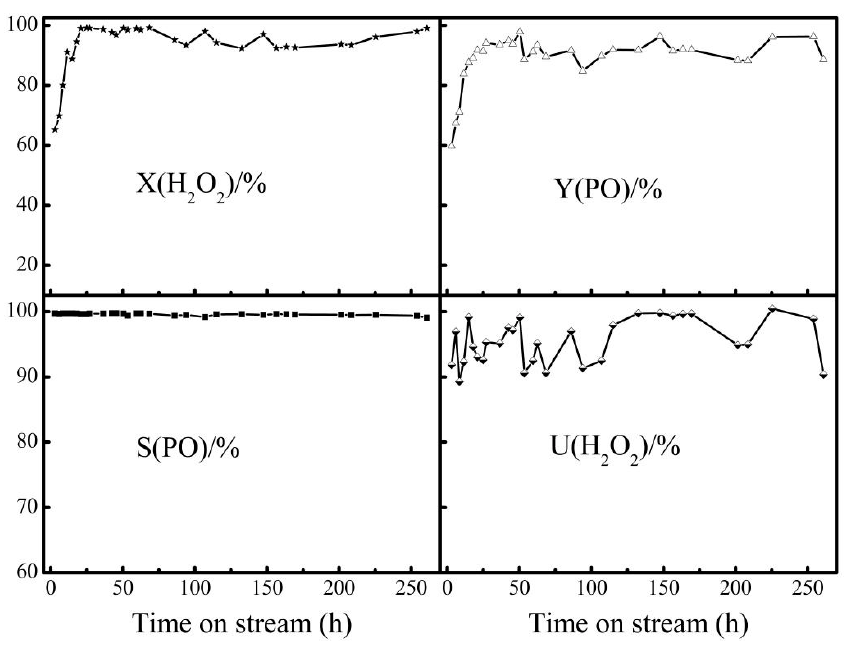
Figure 4. The stability of catalytic performance for E-HPTS-1-8 catalyst in fixed-bed reactor. Reaction conditions: reaction temperature = 42 °C; pH of reaction solution = 9.10; n(C 3 H 6 )/n(H 2 O 2 ) = 2.1; WHSV of propene = 0.64 h − 1 . Table 4. Catalytic performance of fresh and regenerated E-HPTS-1-8 in batch reactor.